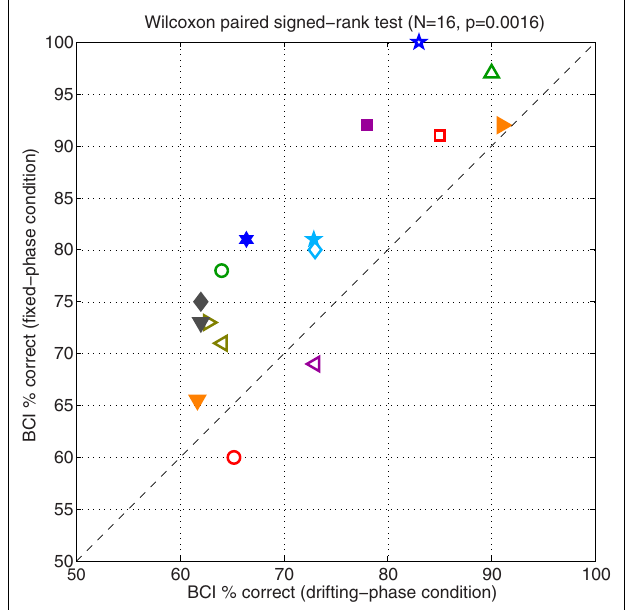
FIGURE 2 |This figure shows the main results of Experiment I. Each symbol represents data for a particular subject. Performance on the fixed-phase condition is plotted against performance on the drifting-phase condition. Performance is calculated as the average accuracy of the classifier, calculated across the 100 online trials available in each condition. Accuracy due to chance was 50%. Open symbols denote subjects who started with the DP condition; filled symbols denote those who started with